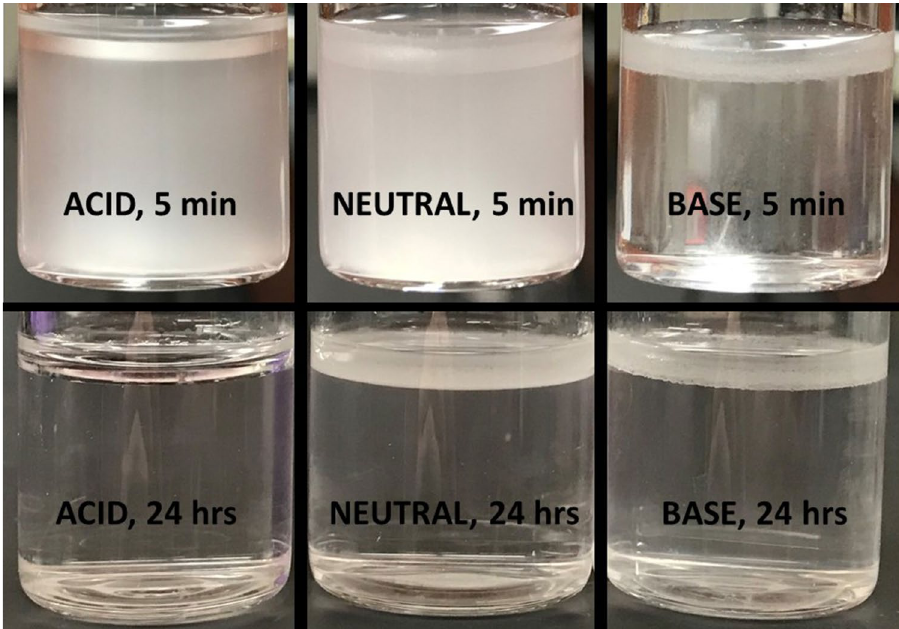
Figure 1. Separation between THF and water with 0.125 M lauric acidic, at basic, acidic and circum-neutral pH after 24 h (bottom row) and after 5 min (top row). The THF-water mixture contains 30% THF relative to water, v/v. Images collected 5 min after mixing with 1 M lauric acid are in the supporting information (Fig.